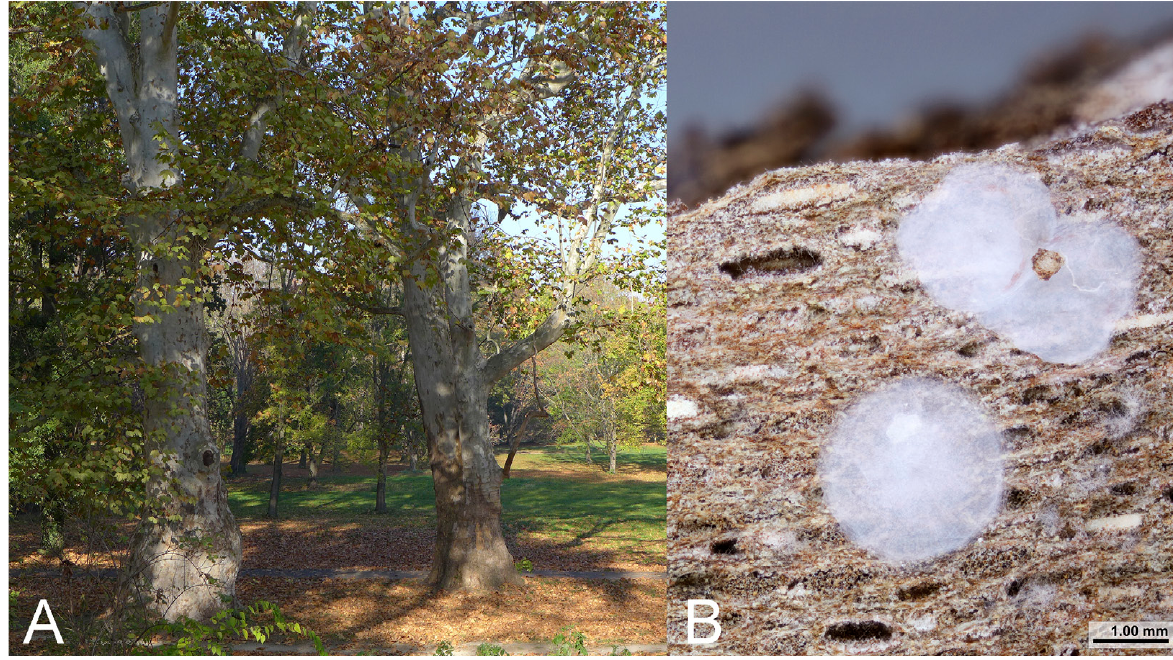
Figure 2. Habitat of Apocheiridium ferum and Cheiridium museorum in Hungary. A. Platanus occidentalis in Várkert-Castle Park. B. Silk chambers under the tree